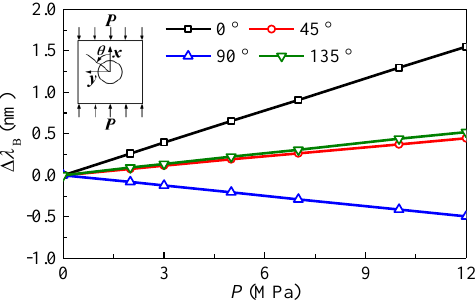
Figure 10. Variation of wavelength shifts of FBGs bonded onto four rings with applied loads.